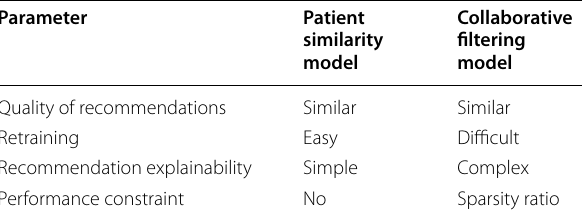
Table 10 Comparison of patient similarity and collaborative filtering